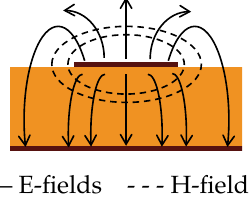
Figure 18. Electric and magnetic field lines for the TEM mode of a coaxial line.